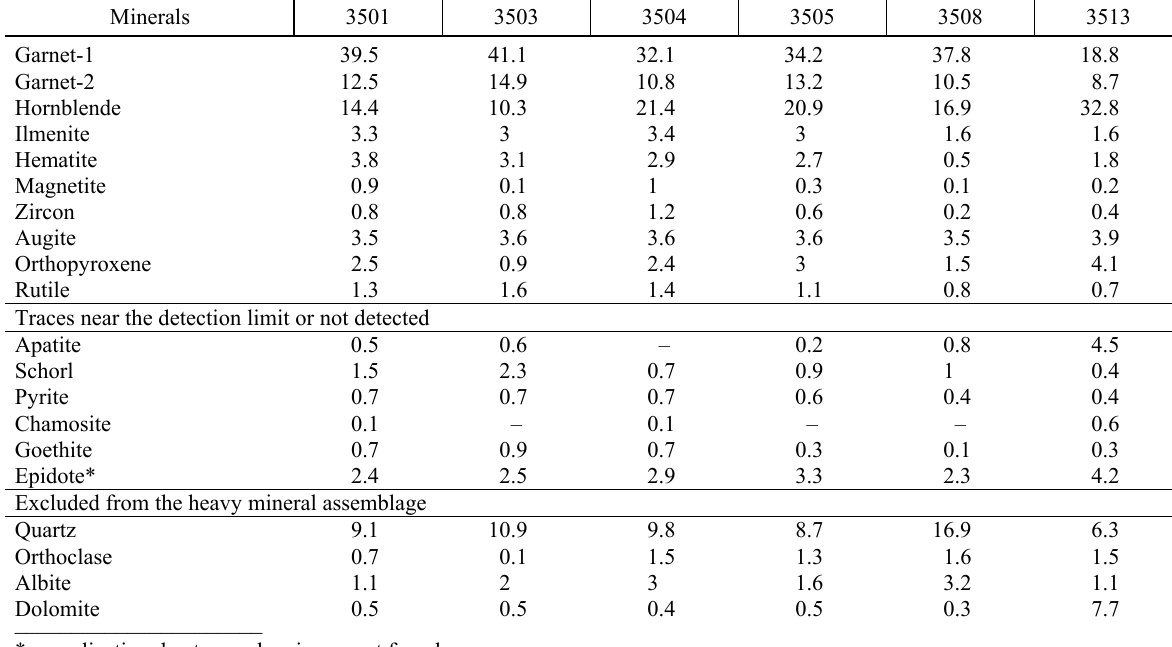
Table 5. Results of X-ray diffractometry of Lemme samples 3501, 3503–3505, 3508 and 3513 using the Rietveld method (wt%, 0.1–0.25 mm fraction)